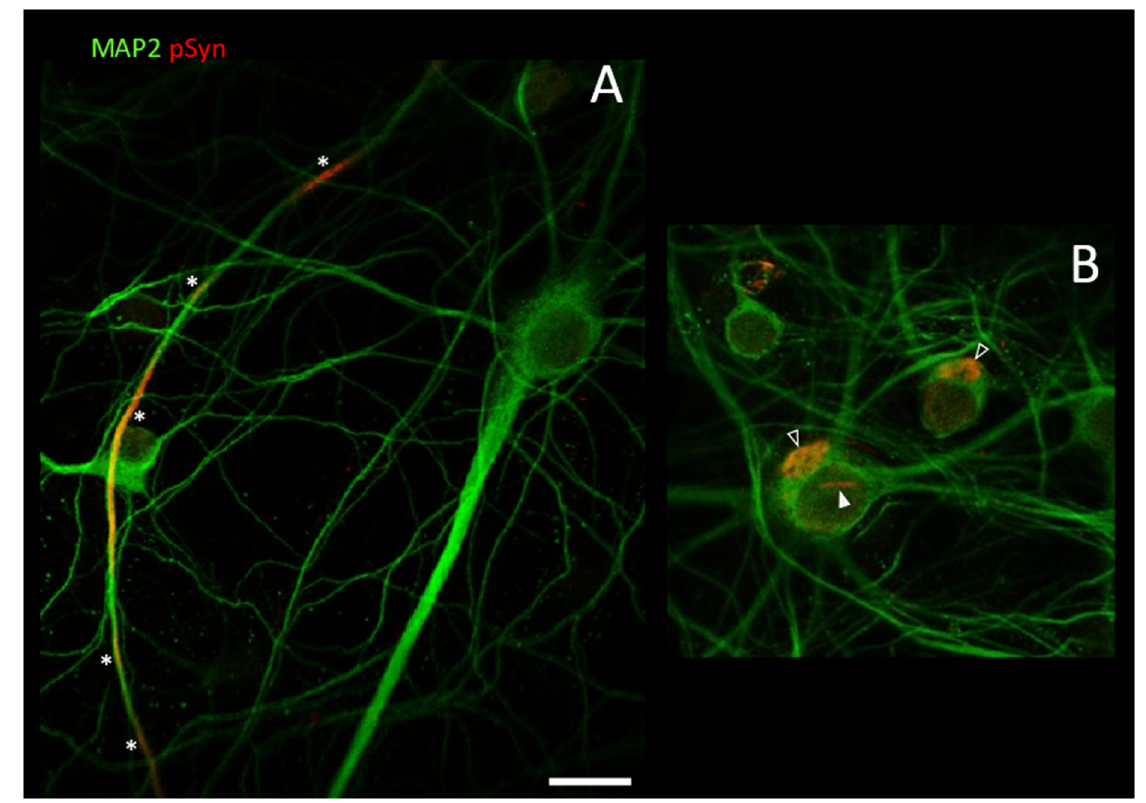
Figure 3. Laser-Scanning Confocal Microscopy (LSCM) optical sections of DIV30 mouse primary cortical neurons treated at DIV7 with 1B fibrils. Phospho-S129 α -Syn-positive inclusions are coded in red (asterisks: neuritic inclusions; empty arrows: NCIs; plain arrow: NII). Neuron-specific cytoplasmic immuno-staining against MAP2 coded in green. Scale bar: 10 μ m. For description of ( A , B ), see text.